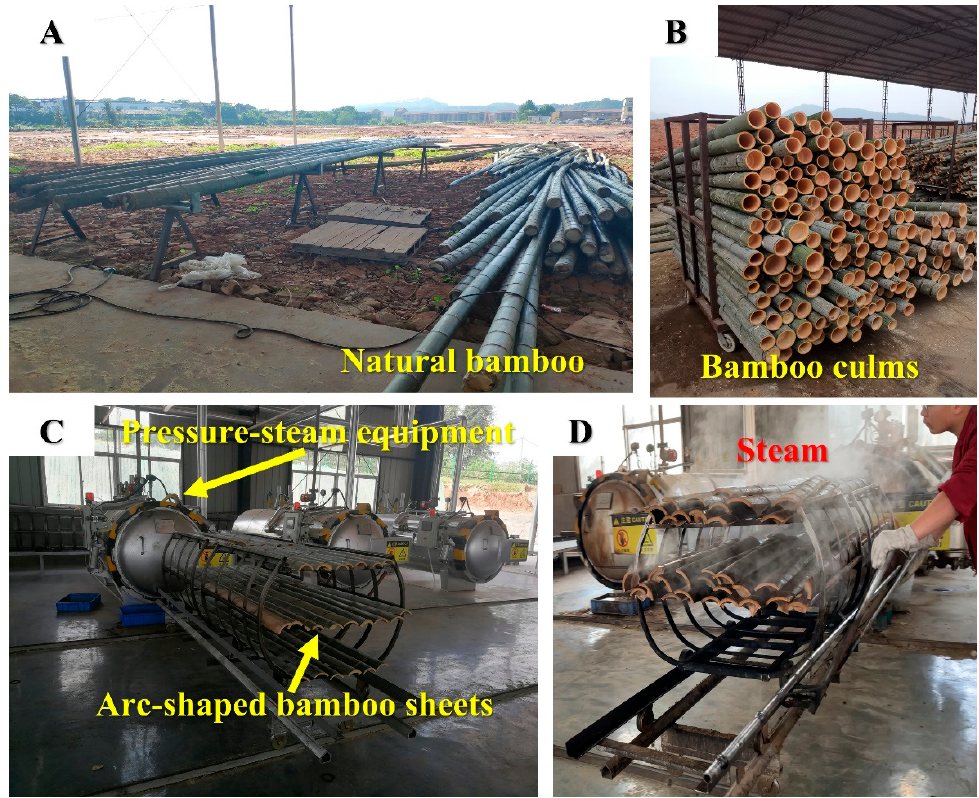
Figure 1. Heat treatment process of bamboo: ( A ) Natural Bamboo in factory; ( B ) Bamboo culms; ( C ) Pressure-steam equipment and arc-shaped bamboo sheets; ( D ) the bamboo sample after saturated- steam heat treatment.